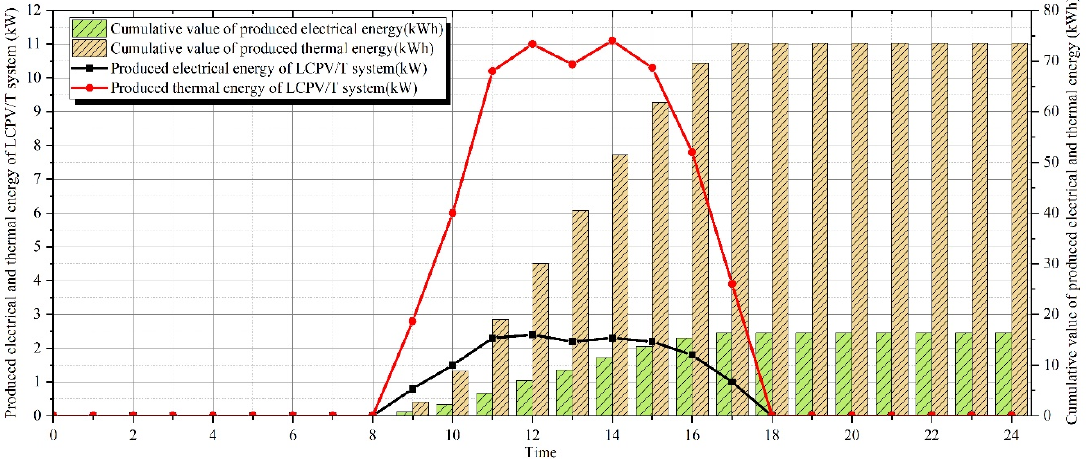
Figure 6. Produced electrical and thermal energy of LCPV/T system during a day (240 h ~264 h).